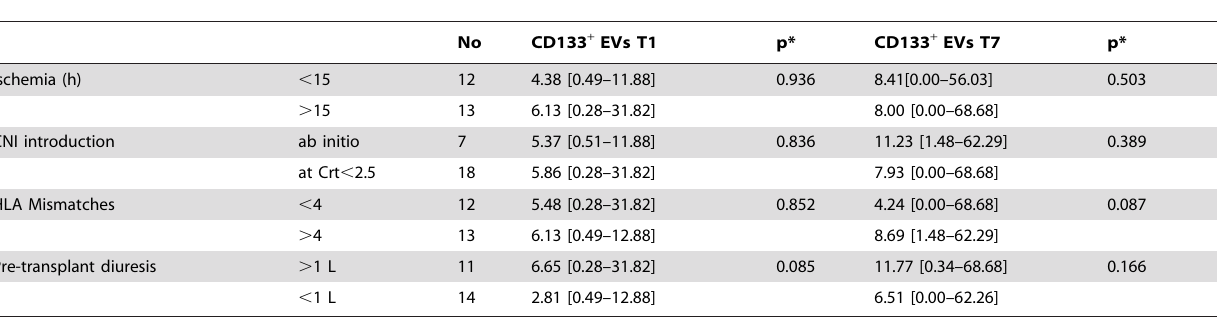
Table 2. Correlation of CD133 + EVs and patients’ clinical